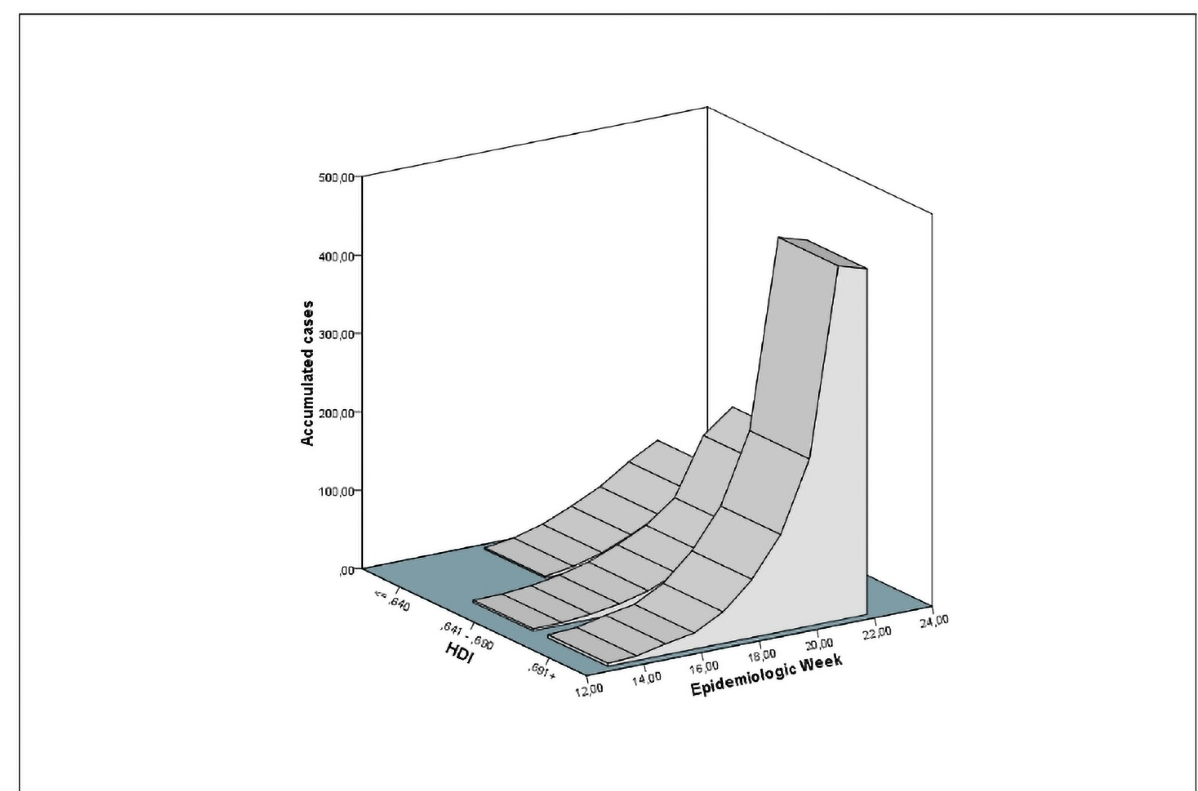
Fig 1. Temporal distribution of COVID-19 cases stratified by the Human Development Index (HDI).